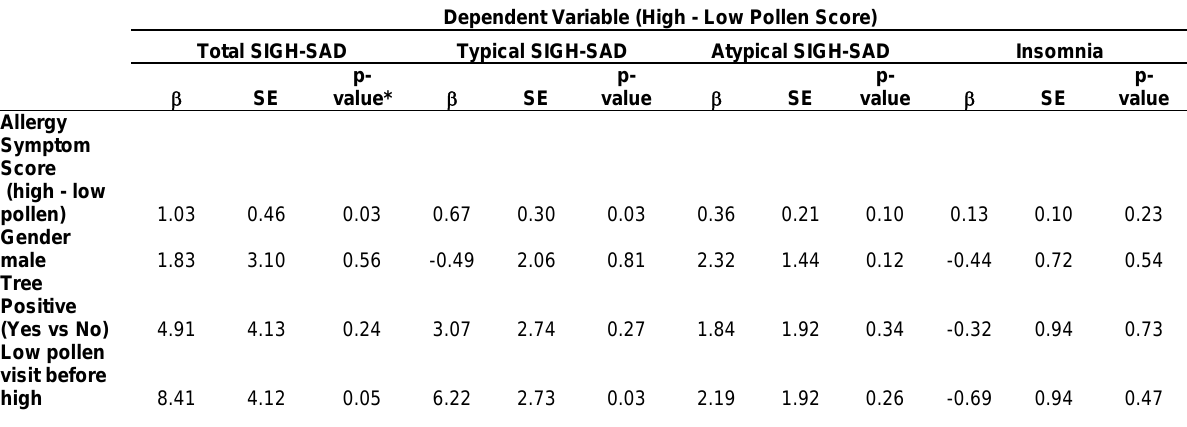
Results of Multiple Linear Regression Analyses of Associations of Change in Allergy Symptom Scores With Changes in Depression and Sleep Scores Dependent Variable (High - Low Pollen